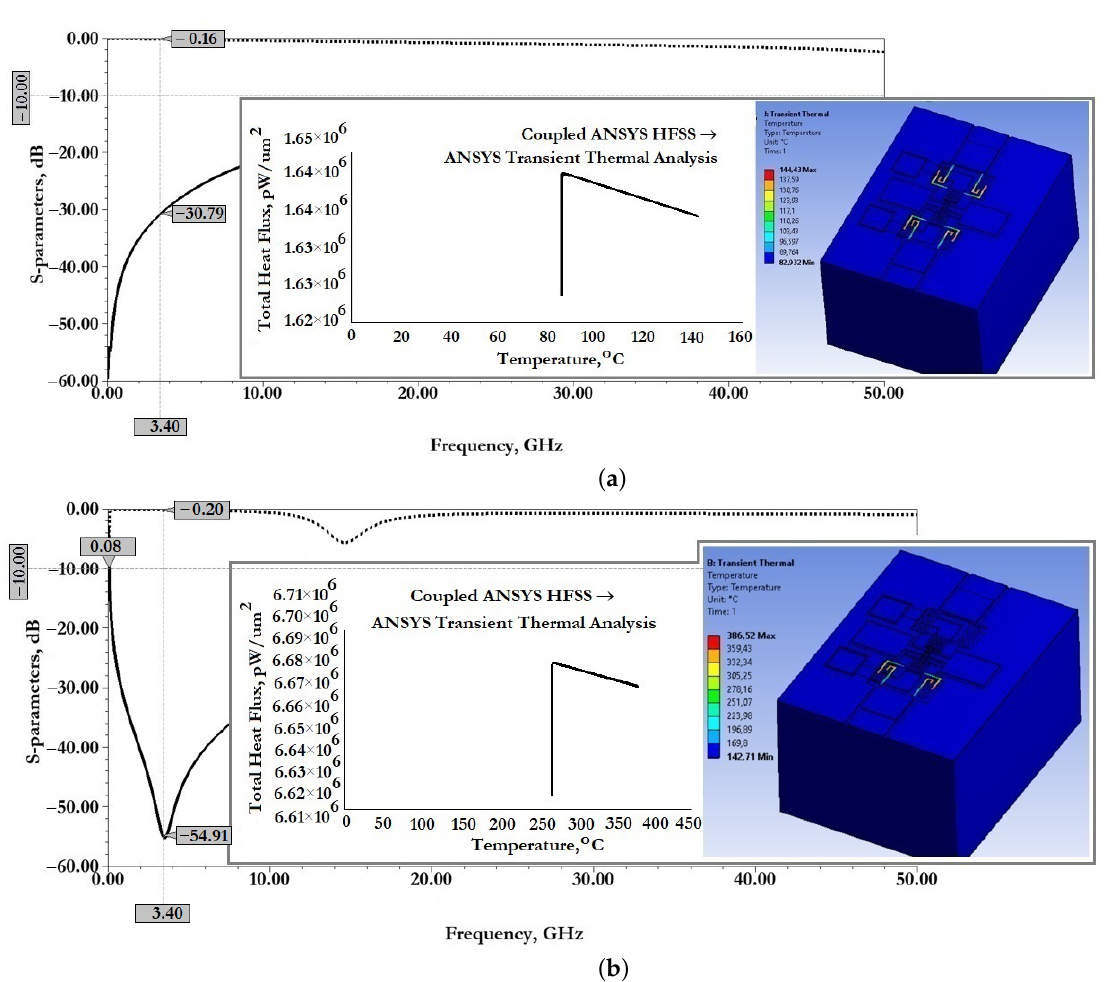
Figure 22. The results of EM and transient thermal modeling of the developed RF MEMS switch (B): ( a ) open state; ( b ) closed